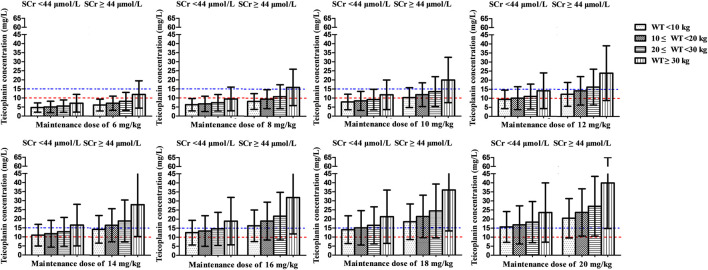
Mean teicoplanin C
min with different maintenance doses in subgroups stratified by weight (WT, kg) and serum creatinine (SCr, μmol/L). Each bar represents the mean ± standard deviation. Maintenance doses were administered once daily and C
min was simulated by day 5 (96 h). The dashed red line and blue line indicate the target C
min of 10 mg/L (moderate infection) and 15 mg/L (severe infection), respectively.